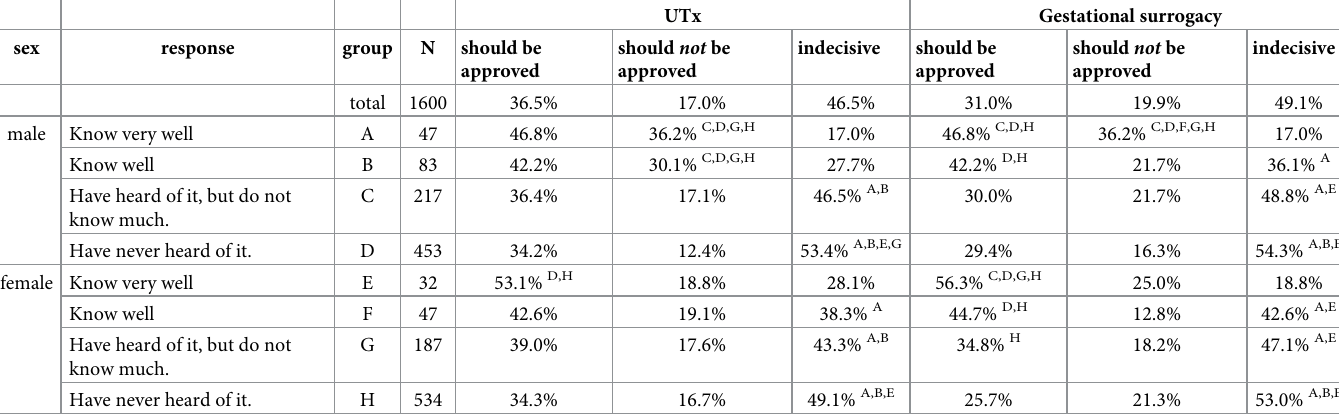
Table 4. The comparison of public attitude towards UTx and gestational surrogacy by degree of understanding of